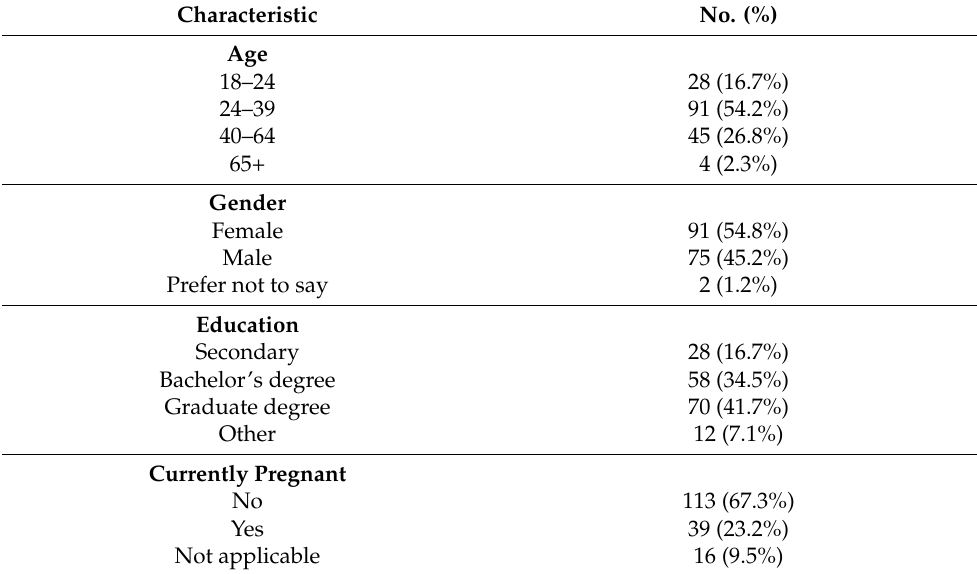
Table 1. Participant characteristics and prevalence of vaccine hesitancy ( n = 168).